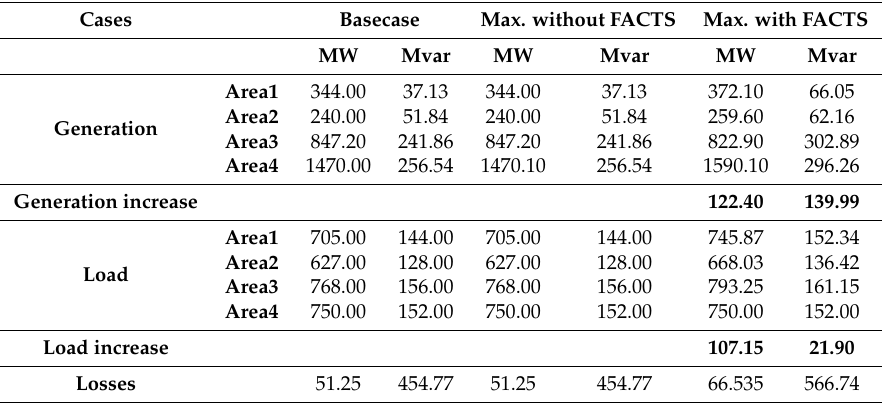
Table 1. Load and generation data of IEEE 24 bus system.